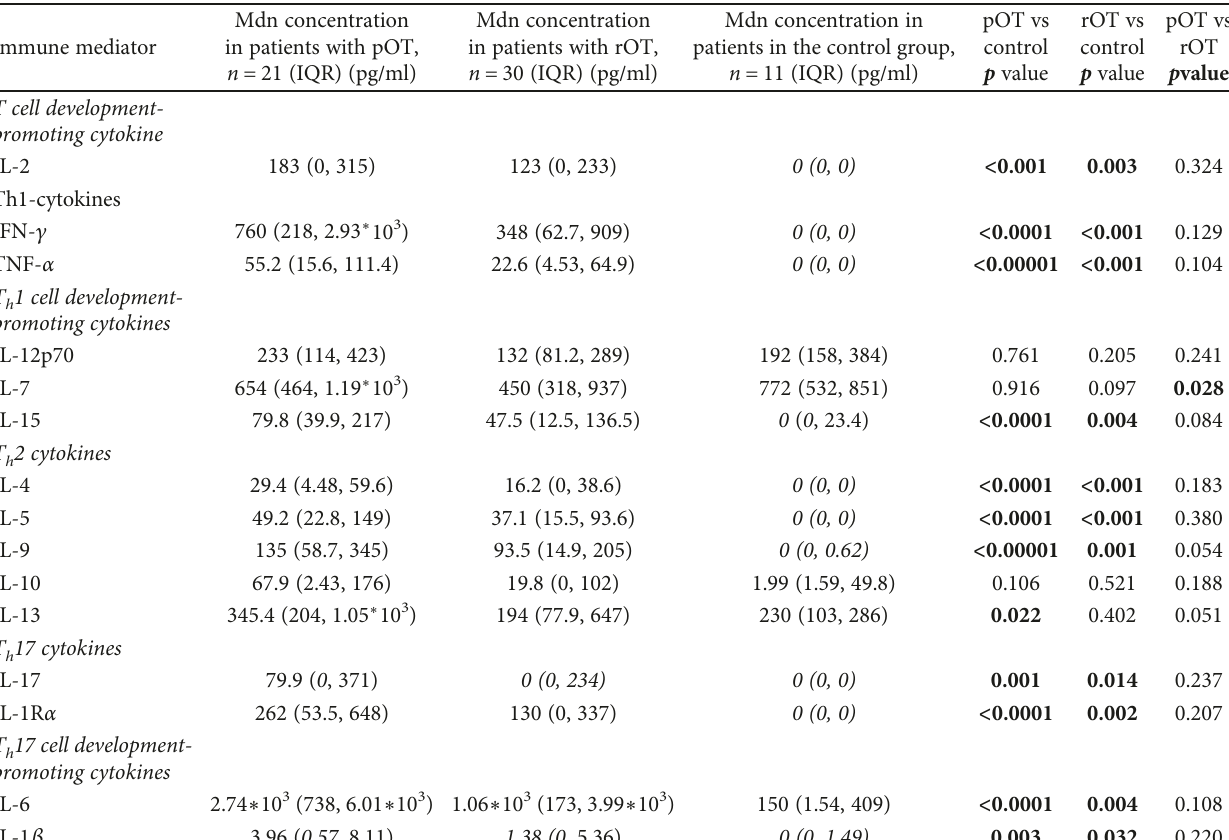
Table 2: Chemokine, growth factor, angiogenetic factor, and wound healing factor concentration in aqueous humor of a control group and patients with pOT and rOT ( n = 62